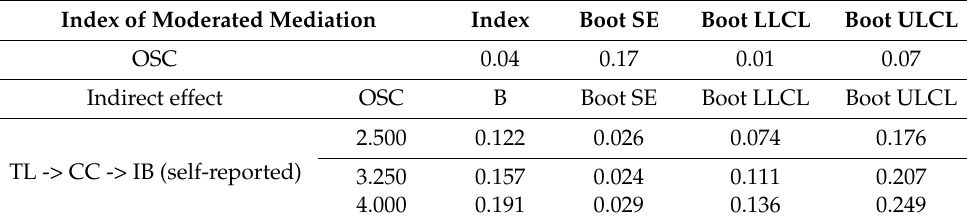
Table 7. Summary of moderated mediation effects for innovative behavior (self-reported).